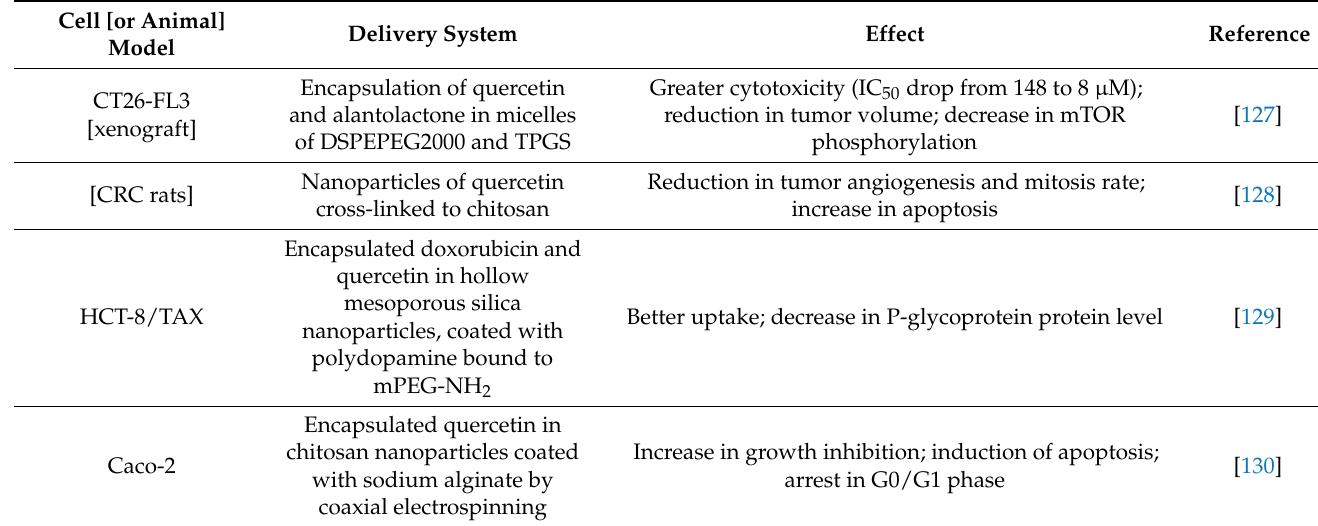
Table 6. Targets affected by quercetin in different delivery systems in CRC experimental models.